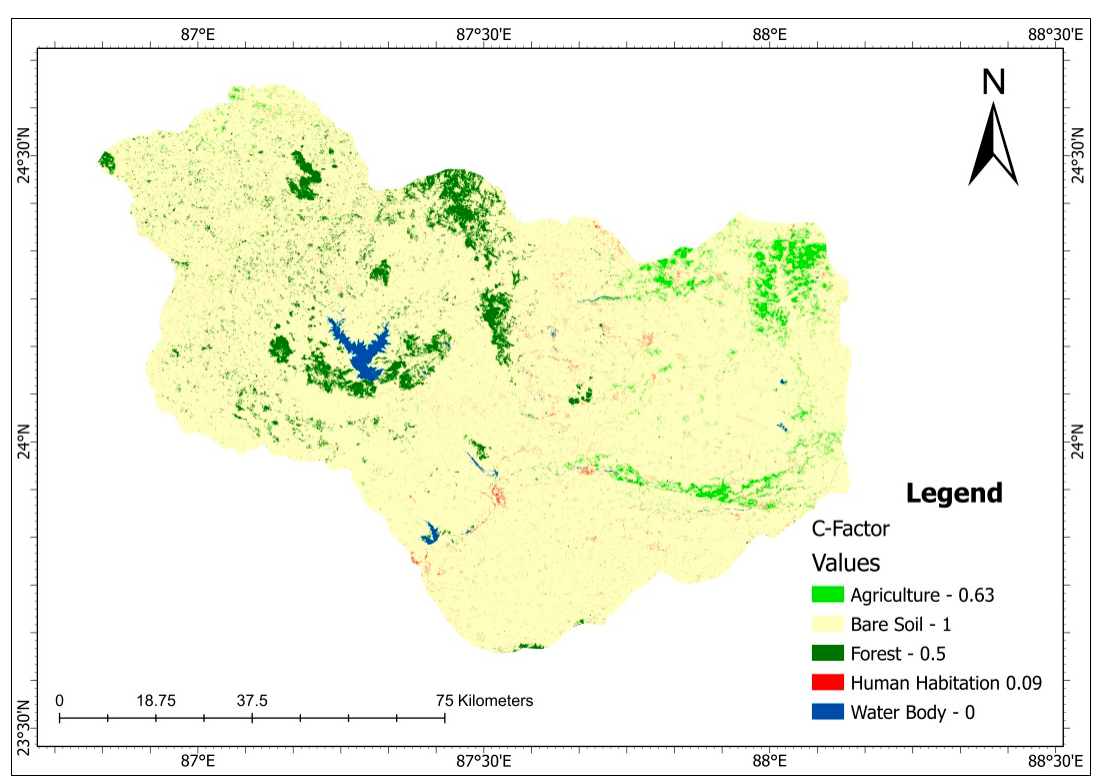
Figure 10. Cover management factor (C) map.